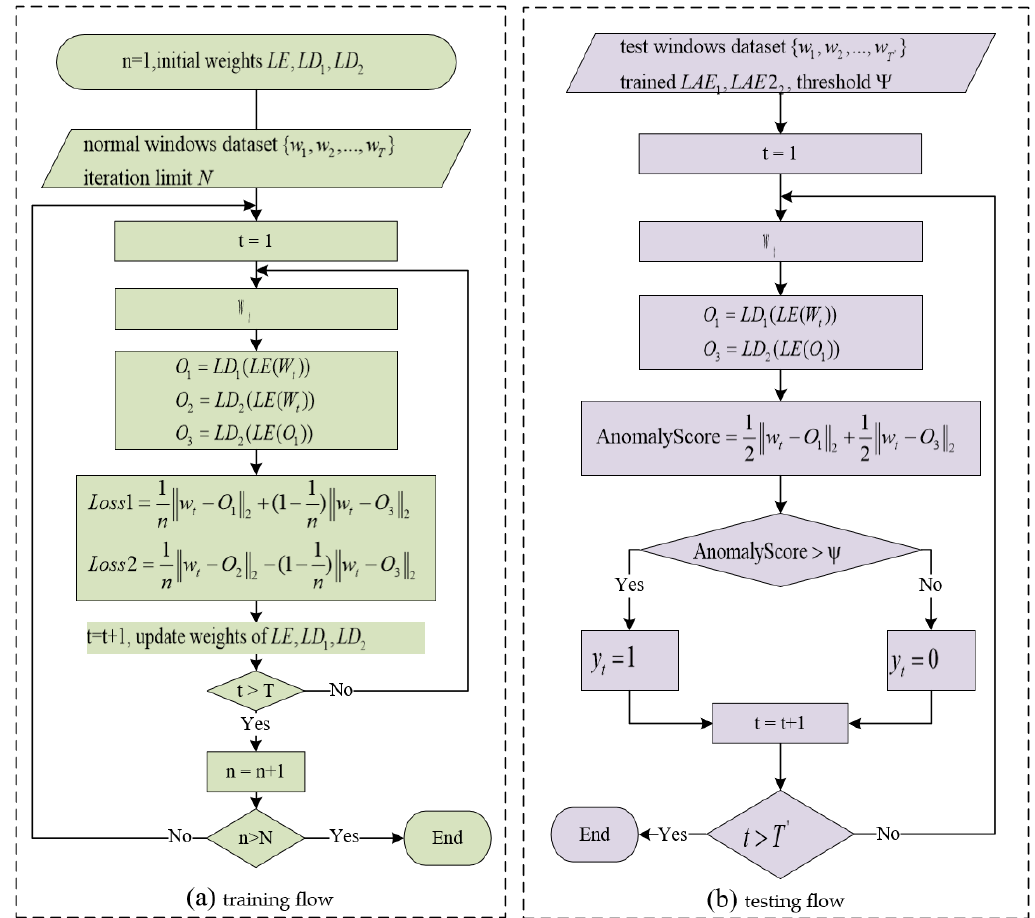
Figure 5. Proposed model training and testing flow chart. ( a ) Training flow chart; ( b ) testing flow chart.